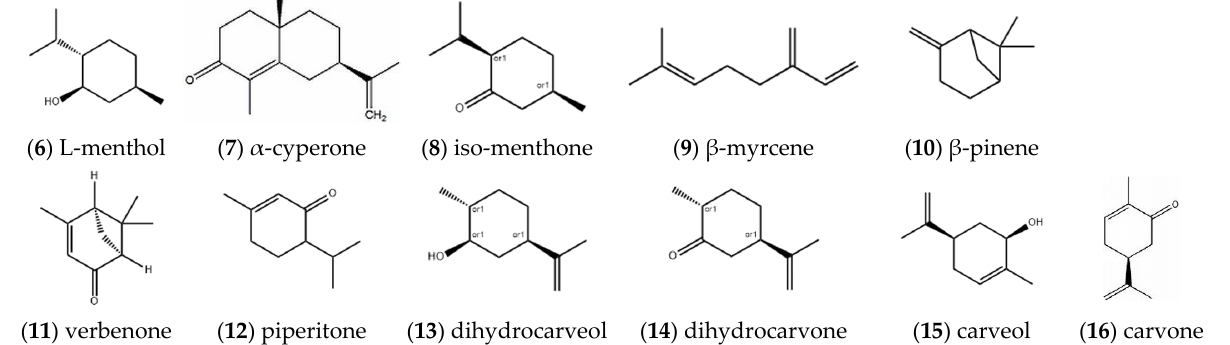
Figure 1. Structures of monoterpenes isolated from ST .